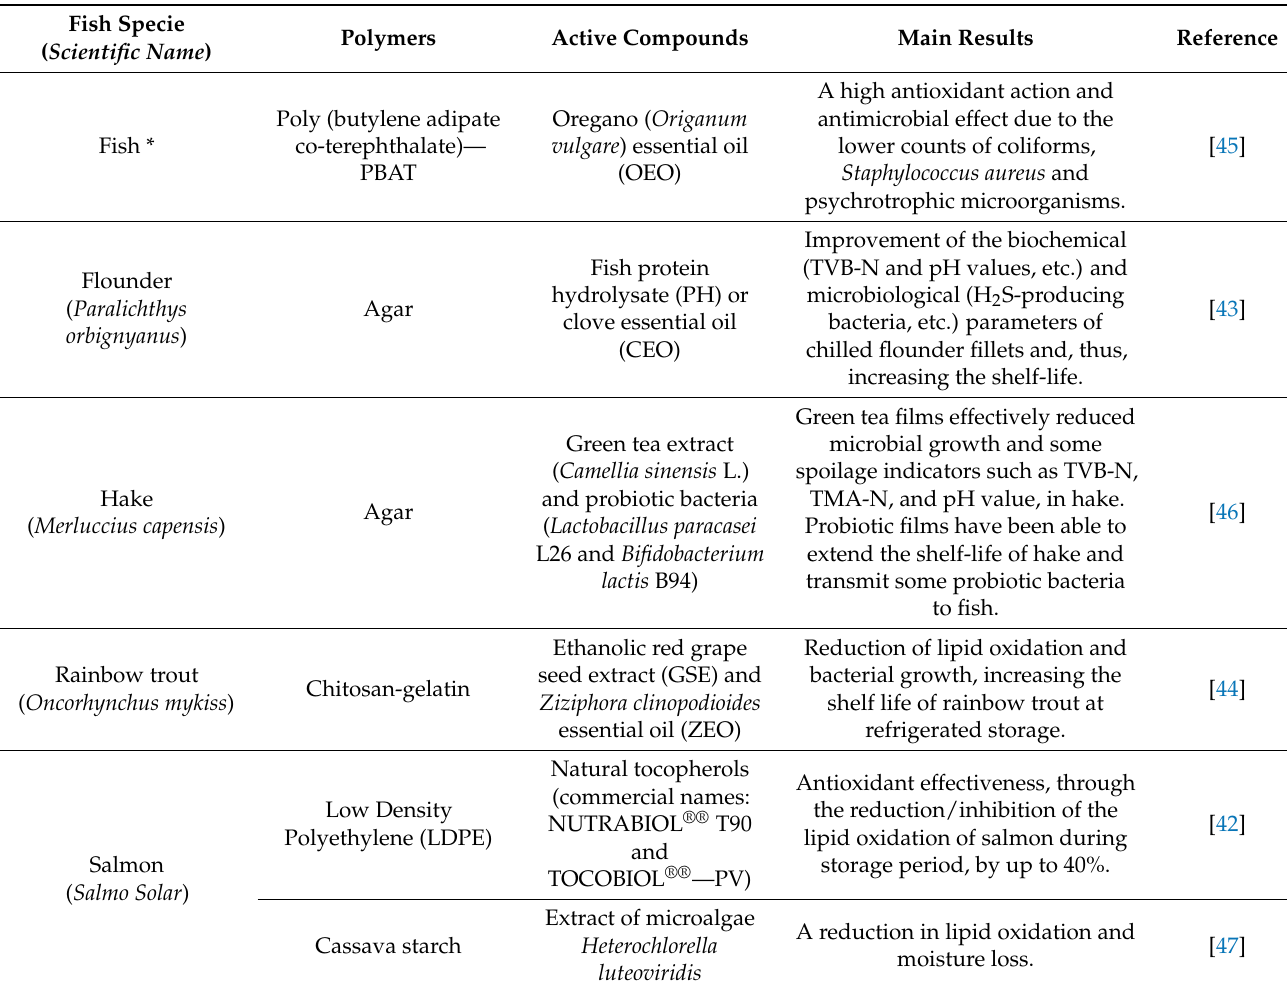
Table 2. Natural active compounds incorporated into natural/synthetic polymers used for fish and fishery products. Fish